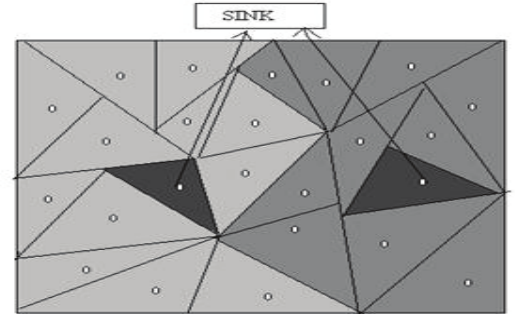
Fig: 3 Transmisson of